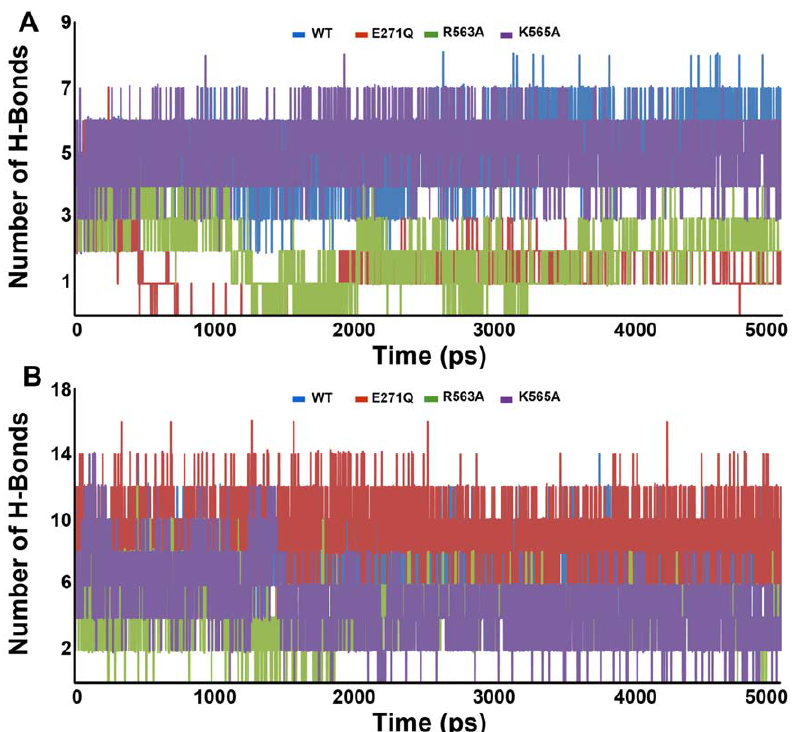
Figure 6. The distribution of number of intermolecular ( enzyme-substrate ) hydrogen bonds during MD simulation. (A) Number of hydrogen bonds between the protein and LTA4. (B) Number of hydrogen bonds between the protein and